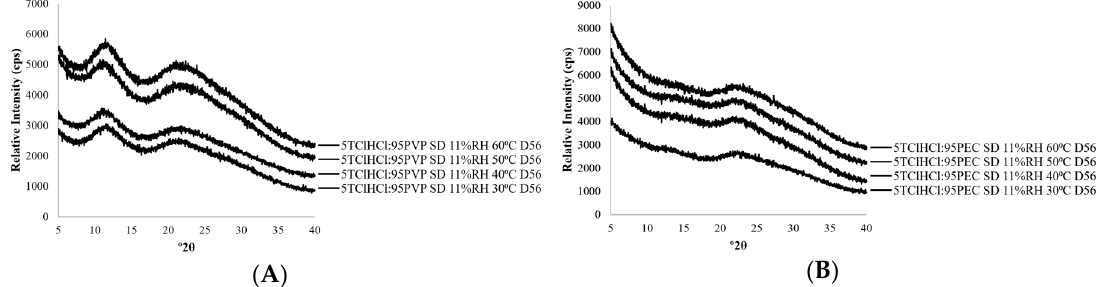
Figure 2. X-ray powder diffraction patterns of ( A ) 5TClHCl:95PVP and ( B ) 5TClHCl:95PEC solid dispersions (SDs) stored at 11% RH and 30–60 ° C on day 56.